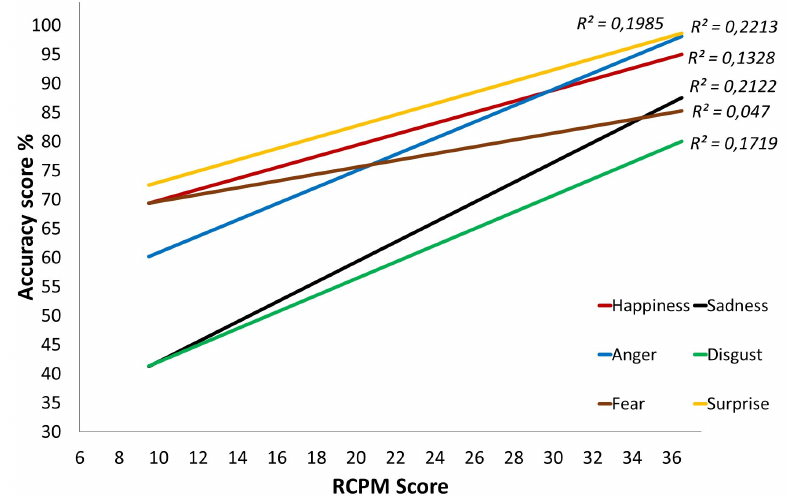
Figure 3. Cross ‐ sectional developmental trajectories for the six basic emotions over Raven’s Colored Progressive Matrices (RCPM) scores, Typically Developing (TD) group.